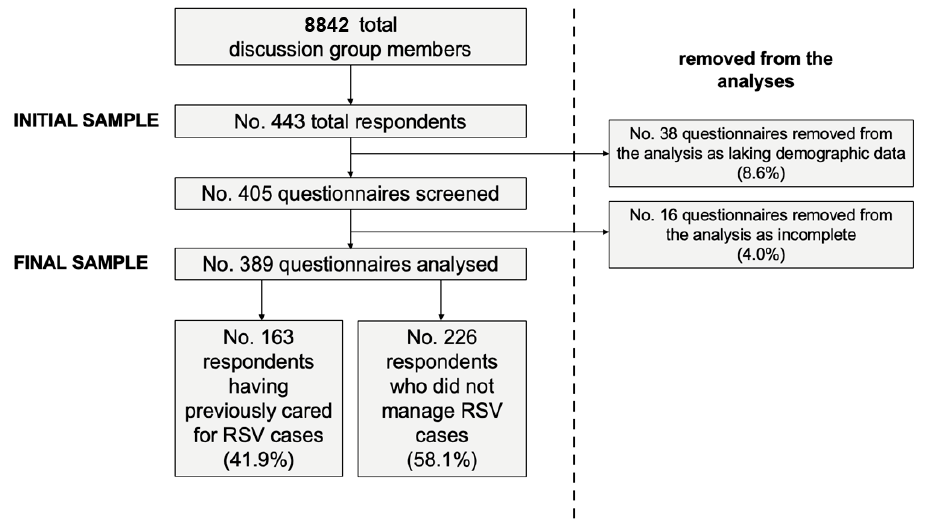
Figure 1. Flow chart of the selection of study participants. The majority of pediatricians included in the final sample were females (61.2%), from Northern Italy (i.e., North-Western Italy, 17.7%; North-Eastern Italy 32.6%), with a mean age of 40.1 years ± 9.1 years, and a total seniority (including the years of post-degree qualification) of 13.9 ± 9.0 years (Table